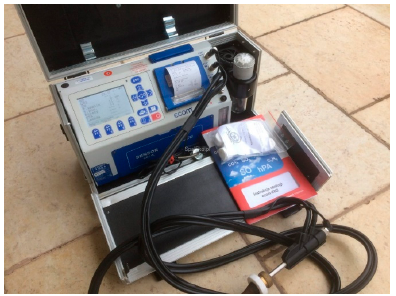
Figure 3. Exhaust gas analyzer with a measuring probe.